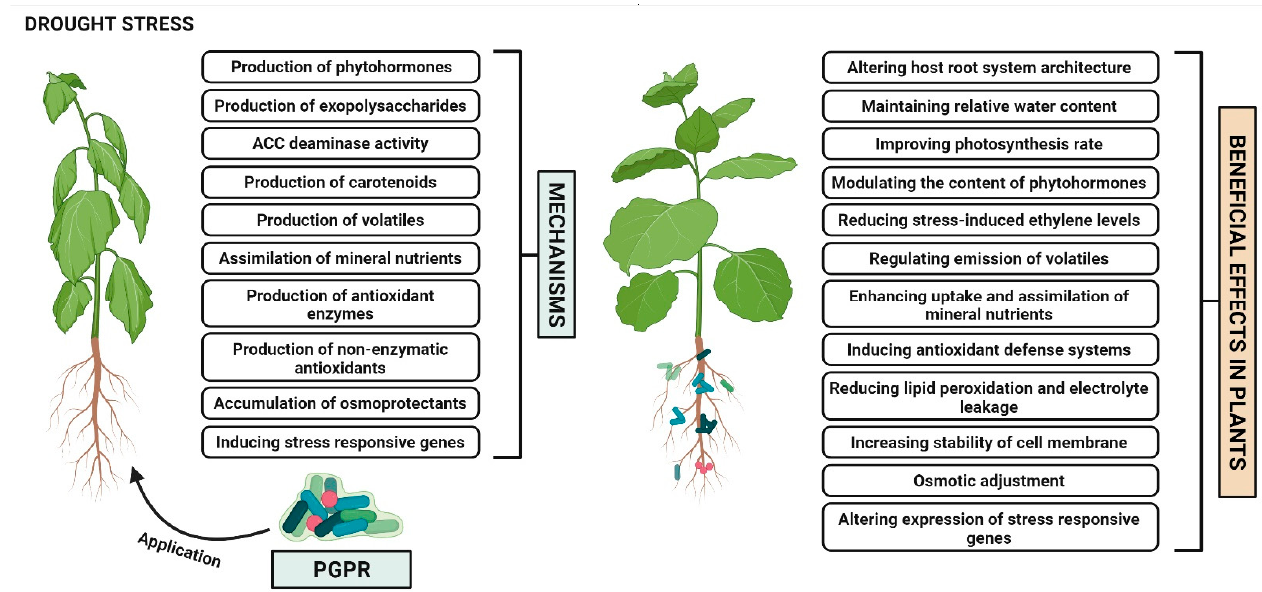
Figure 1. Mechanisms of PGPR-mediated induction of plant drought stress tolerance.